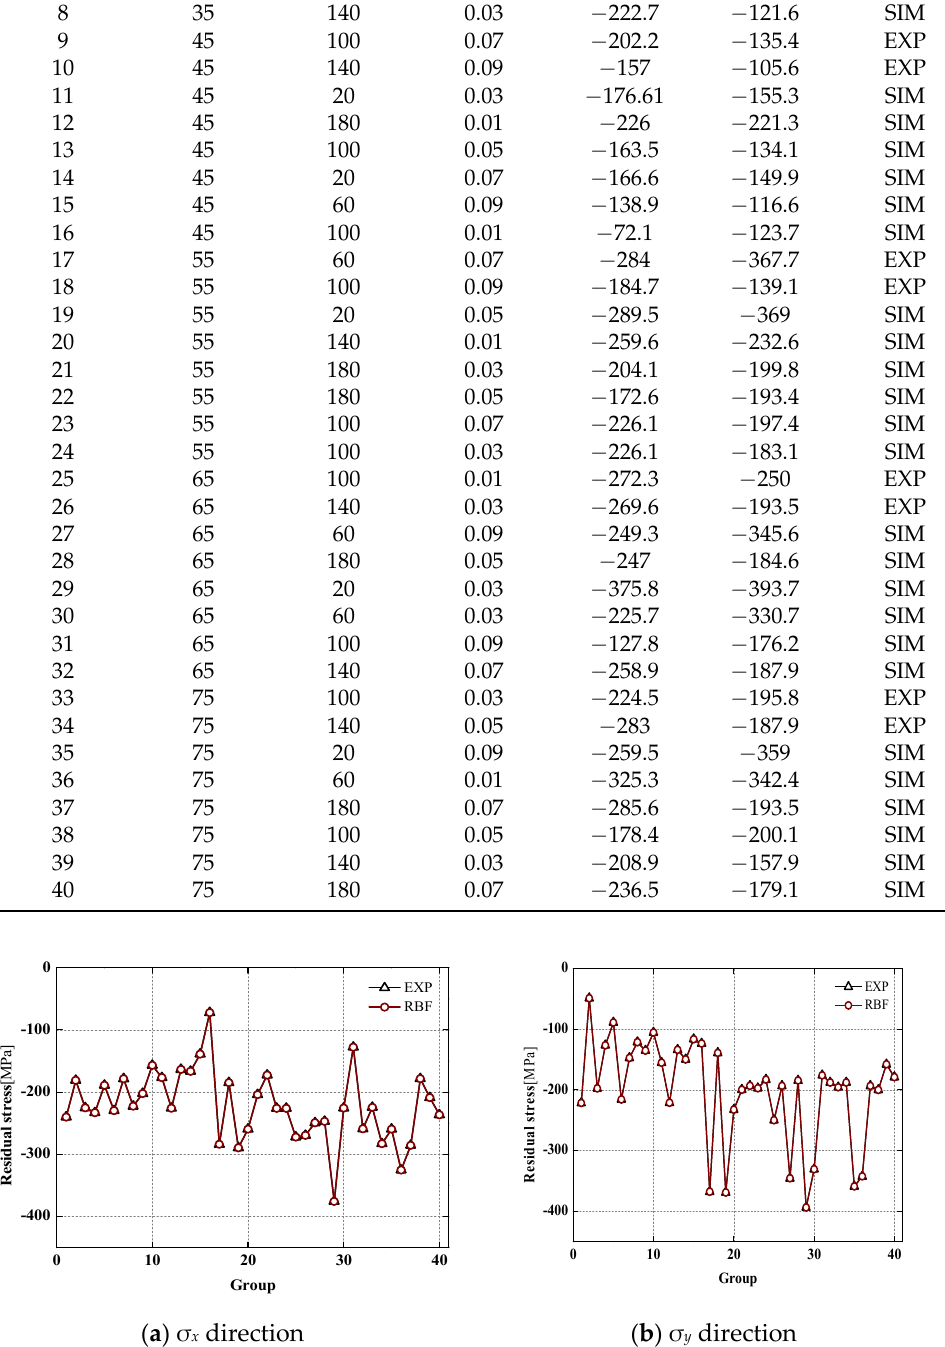
Figure 10. Experimental and predicted coefficients with the trained RBF network.